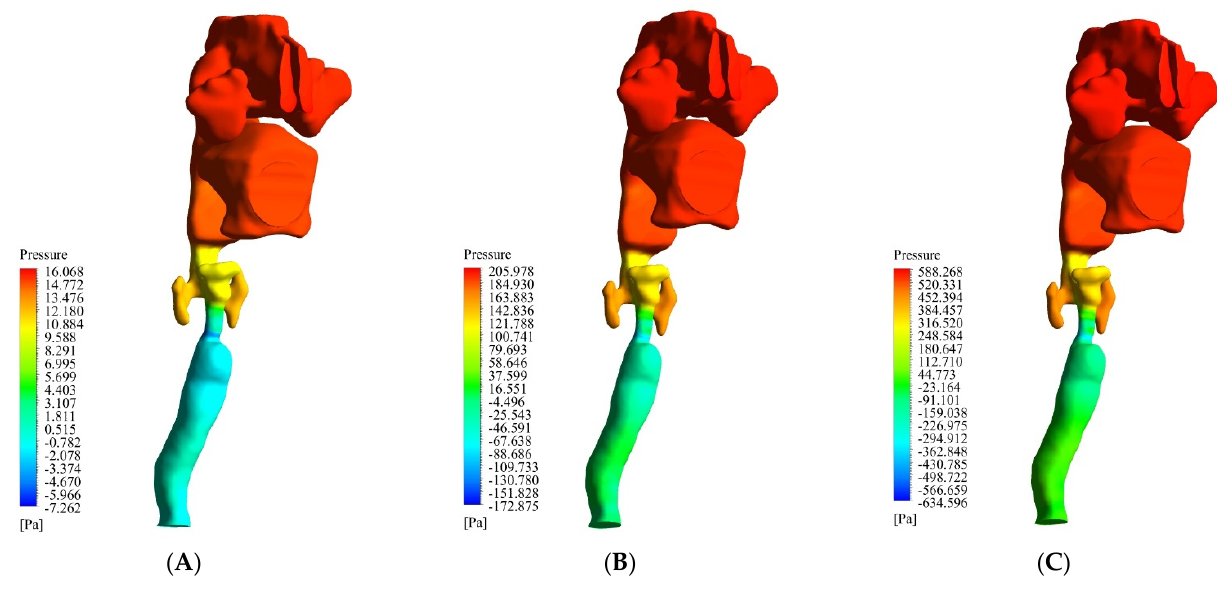
Figure 3. Filled pressure contour of the respiratory system at three flow rates of 13 L/min, 55 L/min, and 100 L/min. ( A ) 13 L/min. ( B ) 55 L/min. ( C ) 100 L/min.